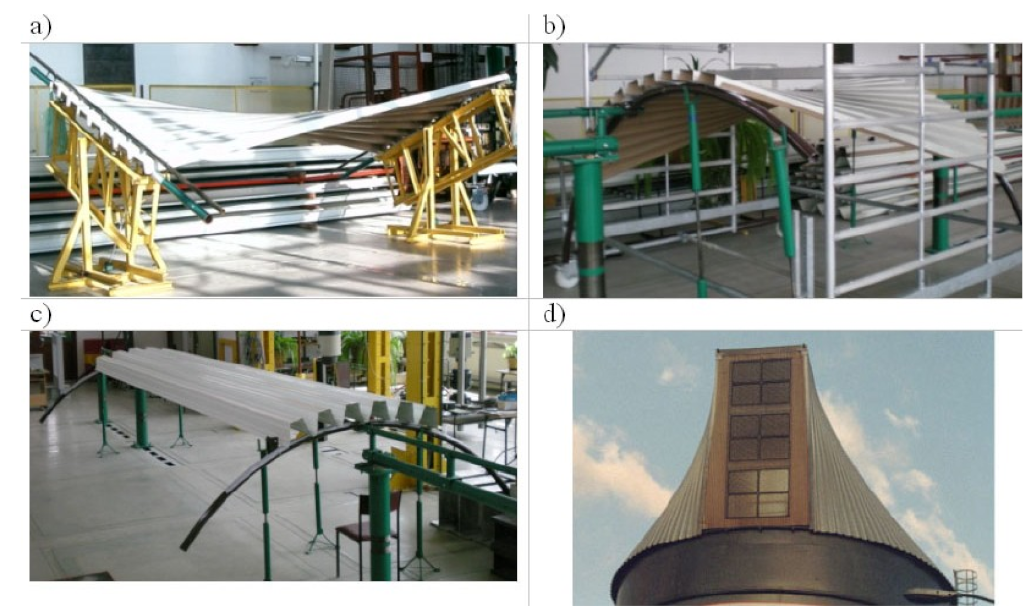
Figure 2. Corrugated shell sheets spread on: ( a ) straight directrices; ( b , c ) curved directrices; and ( d ) straight and curved directrices.